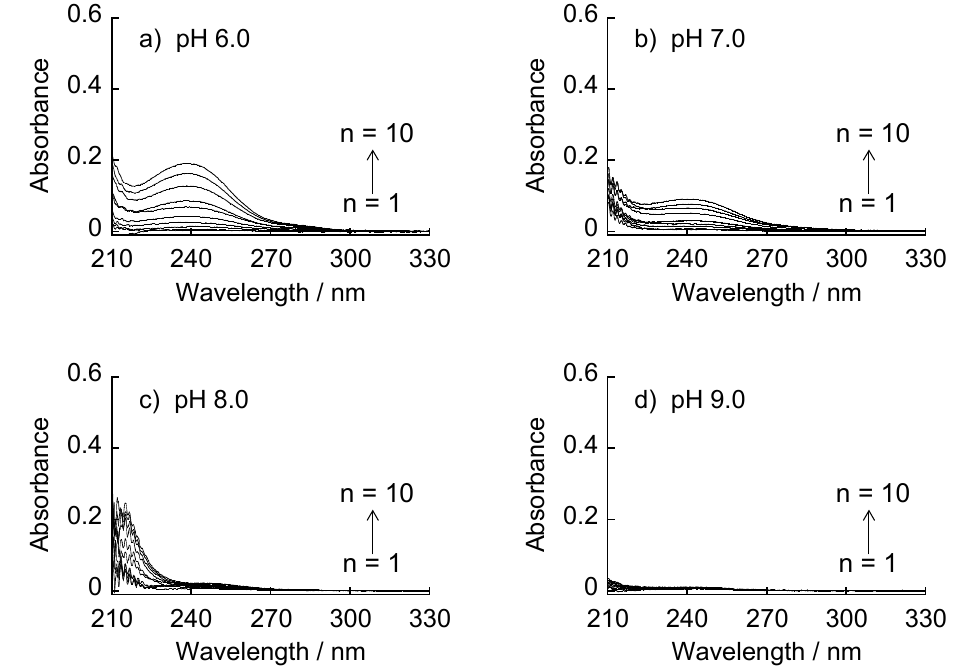
Figure 4. UV absorption spectra of (CMC/39%PBA-PAMAM) n LbL films ( n = 1–10) prepared at pH 6.0–9.0. ( a ) UV absorption spectra recorded at pH 6.0; ( b ) UV absorption spectra recorded at pH 7.0; ( c ) UV absorption spectra recorded at pH 8.0; ( d ) UV absorption spectra recorded at pH